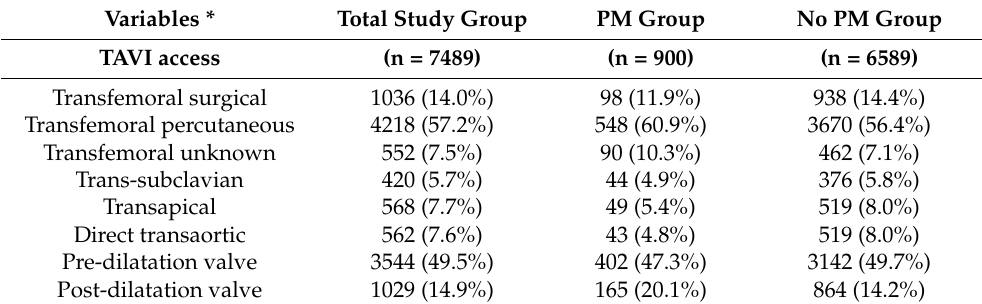
Table 2. Procedural characteristics of patients with or without a 30-day permanent pacemaker (PM) implementation after transcatheter aortic valve implantation (TAVI).